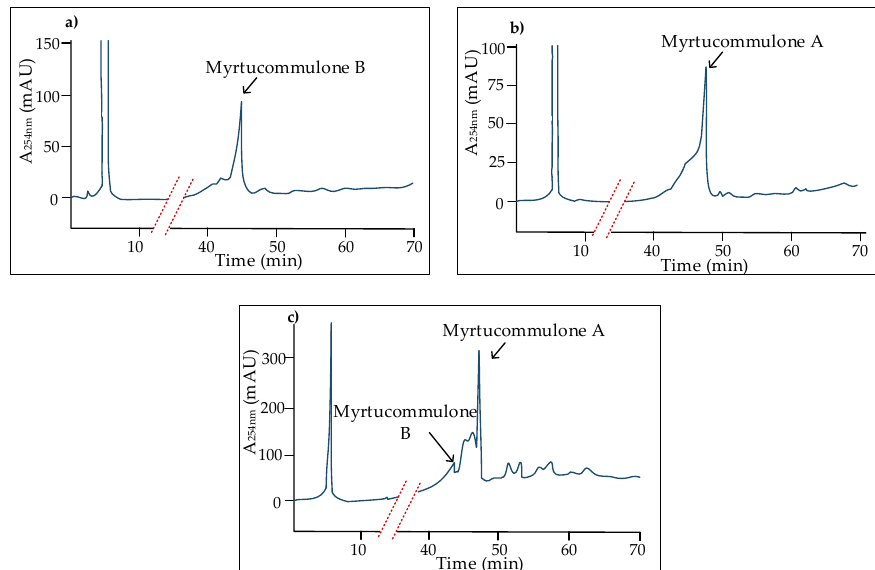
Figure 9. Detection of myrtucommulones A and B through HPLC-DAD analysis in culture extracts of endophytic fungi isolated from M. communis . ( a ) A1304B ( N. australe ); ( b ) A1306A ( H. asterinum ); and, ( c ) M15M2B ( N. italica ). Methods for culturing, extraction and chromatography have been previously reported [73].